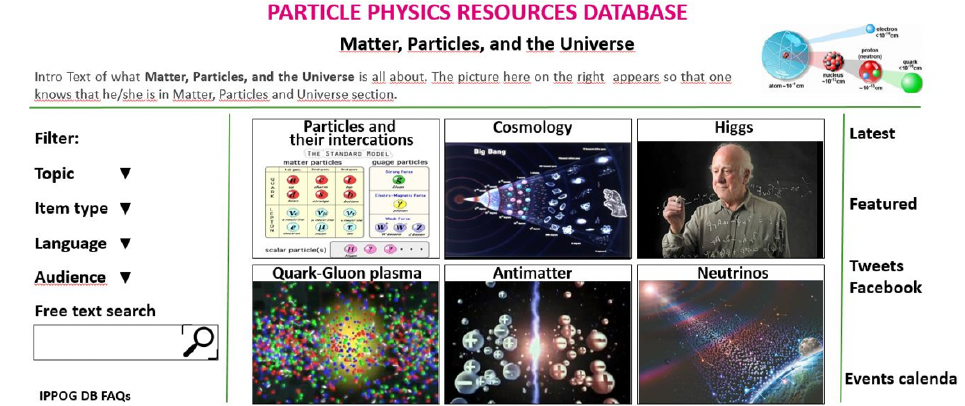
Figure 4. What you see when you click on “Matter, Particles and